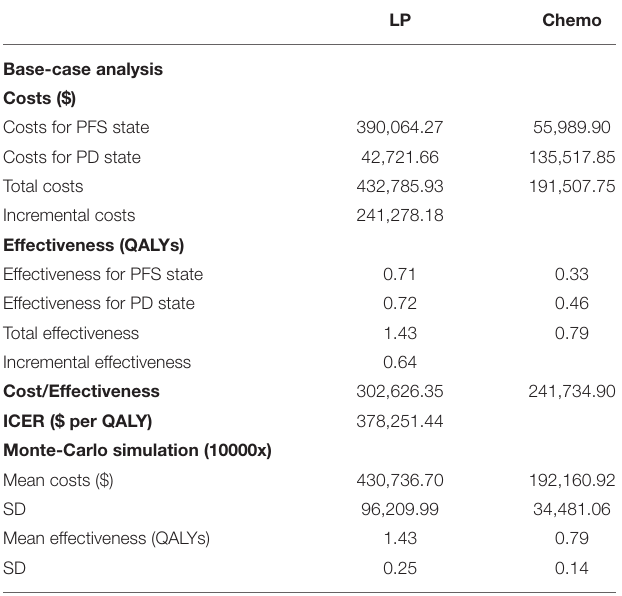
TABLE 3 | Results of the cost-effectiveness analysis in all